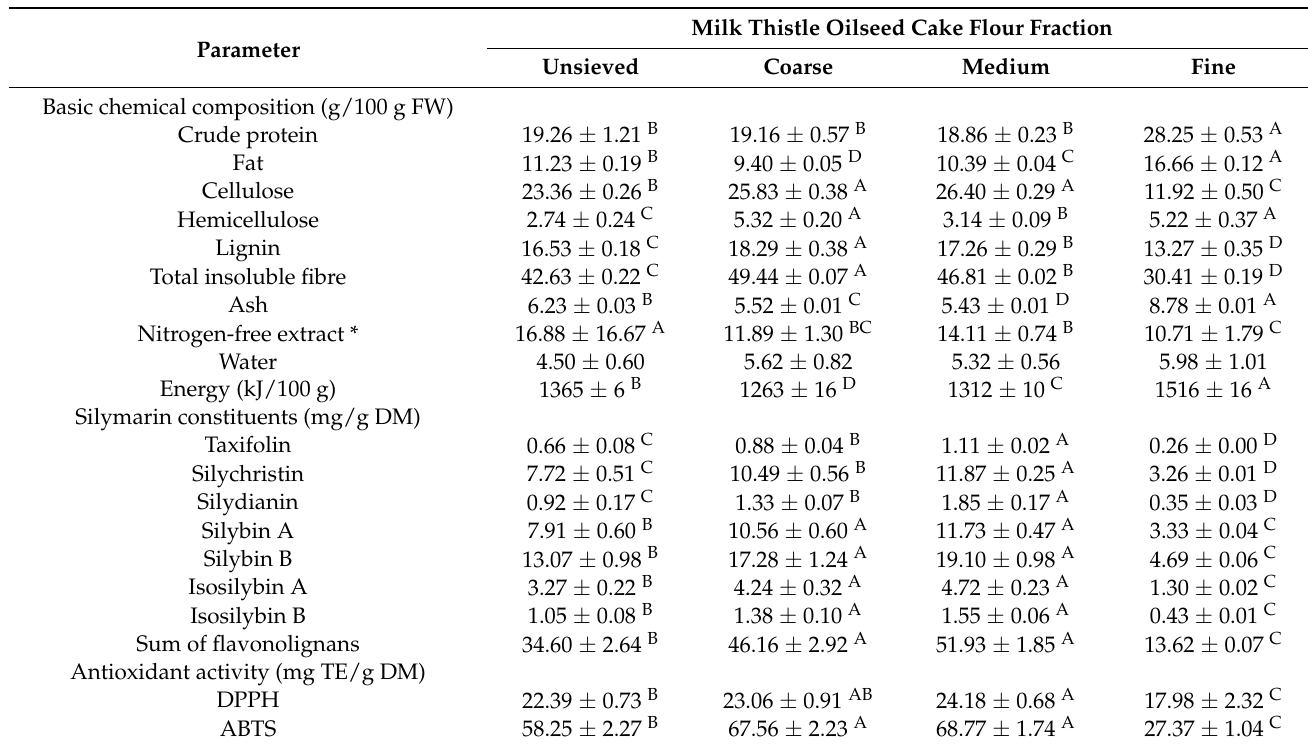
Table 1. Basic chemical composition, content of silymarin constituents and antioxidant activity in the milk thistle oilseed cake flour